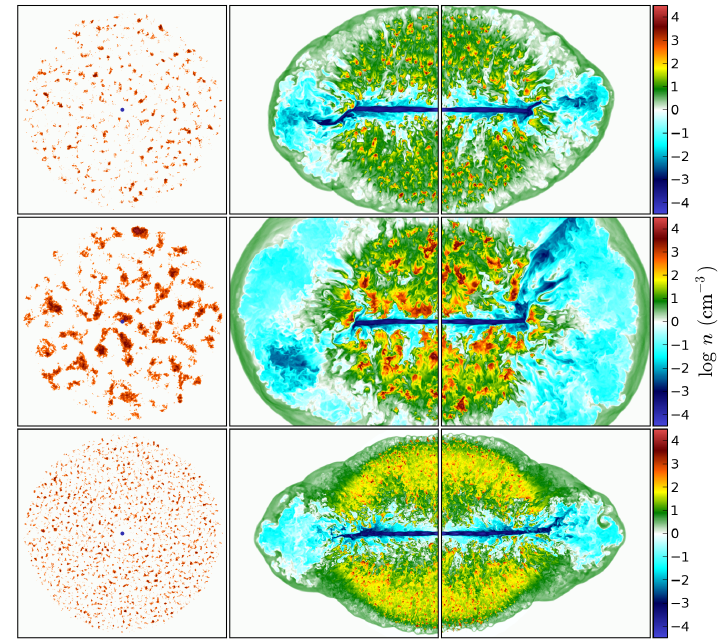
Figure 9. Logarithmic density maps of three simulations of jets propagating through the ISM for different ISM warm gas distributions. Panels are 1 kpc × 1 kpc wide. Left column : Face on view of the initial warm gas distribution. Center and right columns : Midplane slices at an advanced stage of the simulations for z = 0 (reflected about x = 0) and y = 0, respectively. Top row : Very low filling factor run (=0.027); Middle row : maximum cloud sizes of 50 pc; Bottom row : maximum cloud sizes of 10 pc. (Figure 1 of [254] ©AAS. Reproduced with